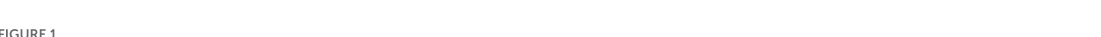
FIGURE1 WT mice. (E) Flow cytometric analysis was performed to determine the number of CD45+CD11b+Ly6G+ cells in the bone marrow (BM), blood, and heart 12 h after intraperitoneal injection with either PBS ( n = 3) or LPS (25 mg/kg, n = 3) in WT mice. (F) Western blot was used to analyze the LCN2 expressions in neutrophils isolated from peripheral blood 12 h post-intraperitoneal injection of PBS or LPS (25 mg/kg, n = 6 in each group) in WT mice. (G) ELISA was performed to detect the LCN2 protein levels in neutrophils after 12-h incubation with either RMPI-1640 or LPS (100 ng/ml, n = 3 in each group). Measurement data are presented as mean ± SEM. * p < 0.05, ** p < 0.01, *** p < 0.001, **** p <